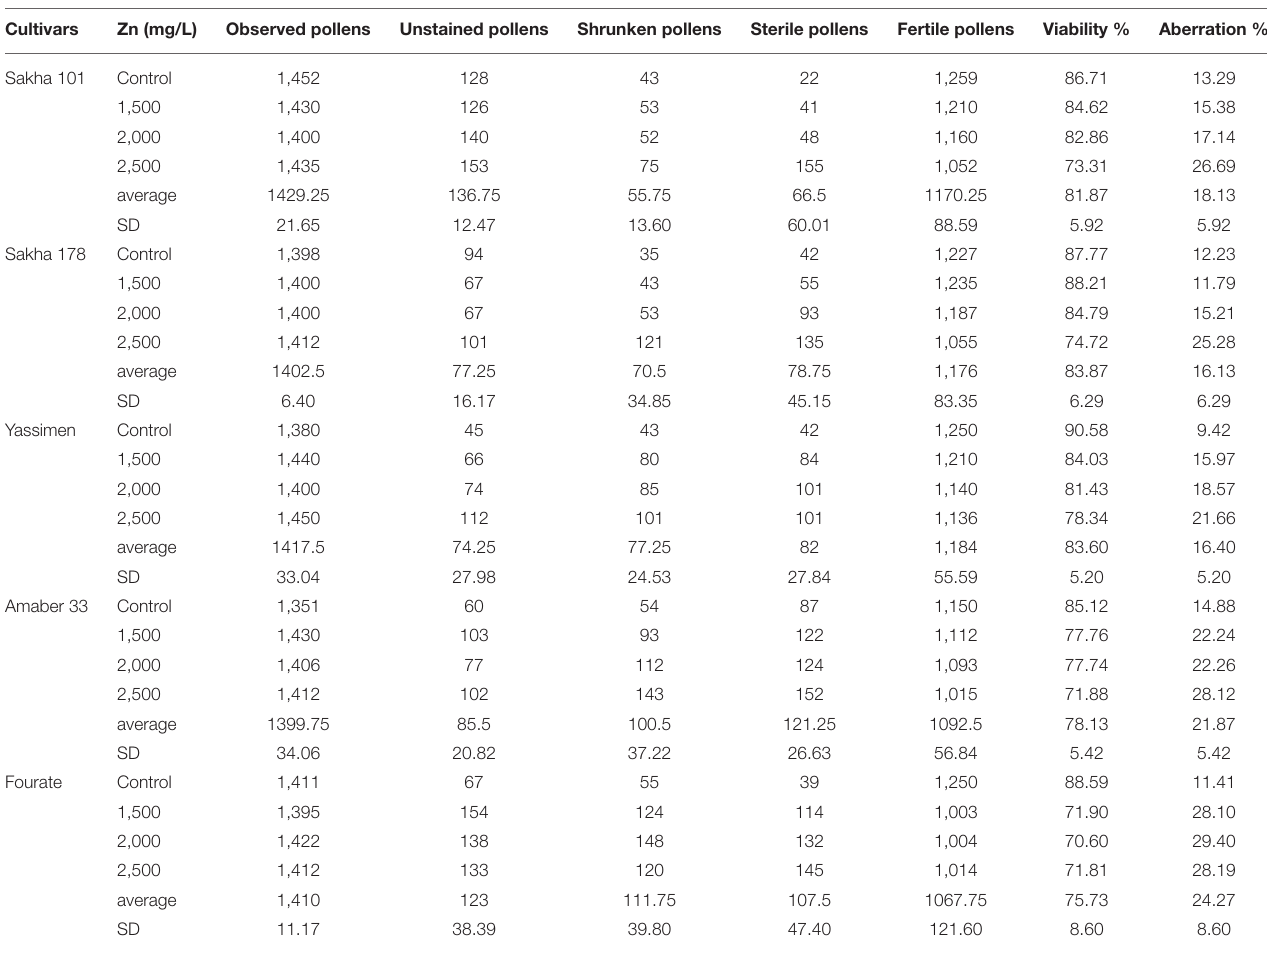
TABLE 6 | Total observed pollen grain, unstained pollen, shrunken pollen, fertile pollen, viability percentage, and aberrations percentage of pollen grain of rice ( O. sativa ) in response to the different concentrations of Zn fertilizers.